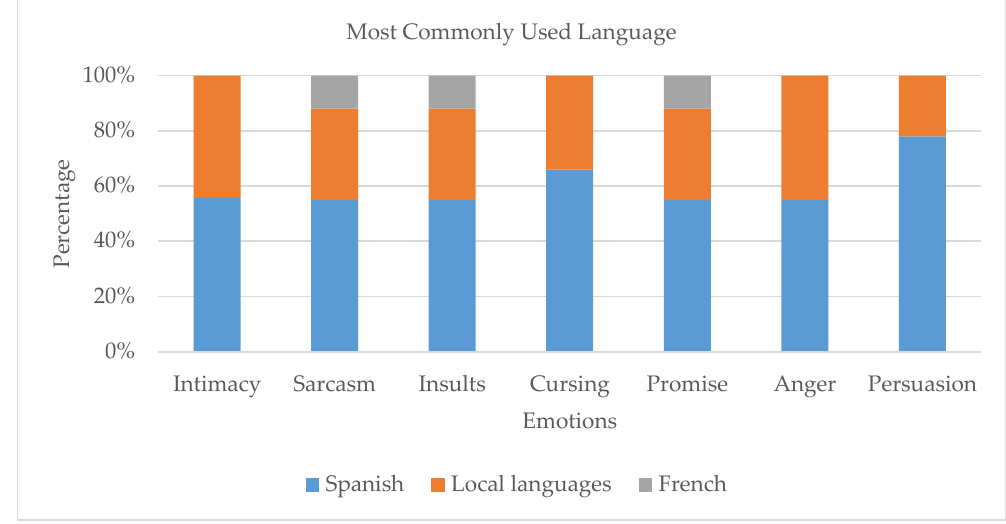
Figure 4. Commonly-used language to express emotions.